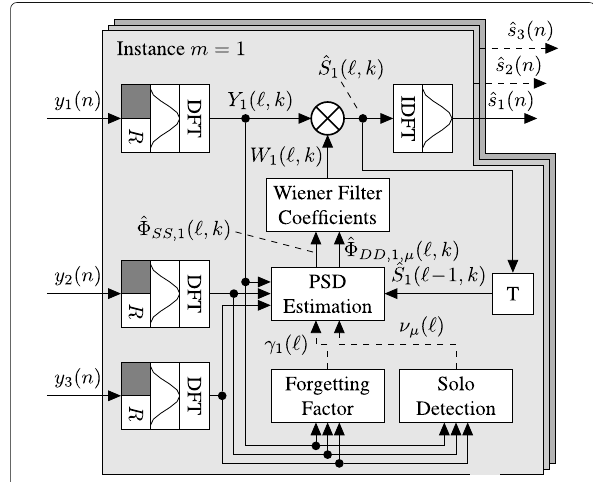
Fig. 4 MWF approach for speaker m = 1. The box denotes the buffering of the previous K − R samples. With the aid of a PSD estimation, a Wiener filter W 1 ((cid:4) , k ) is adapted to reduce the interferer signals in microphone channel y 1 ( n ) . As indicated by the three layers, microphone channels y 2 ( n ) and y 3 ( n ) are enhanced by changing the input signals